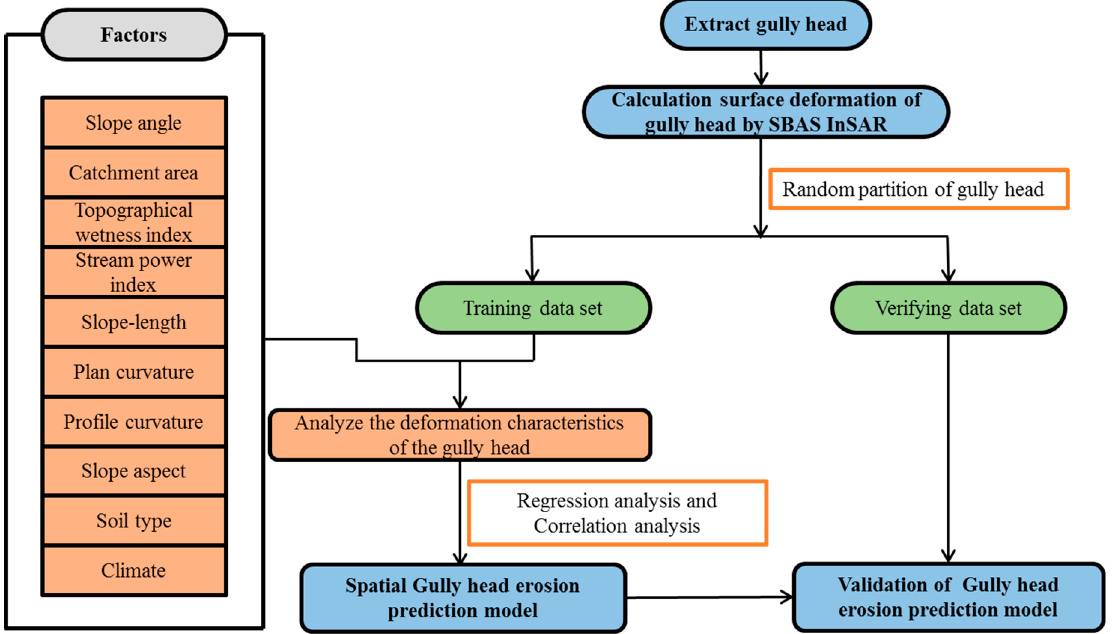
Figure 4. A flowchart of the methodology for the spatial model of gully head